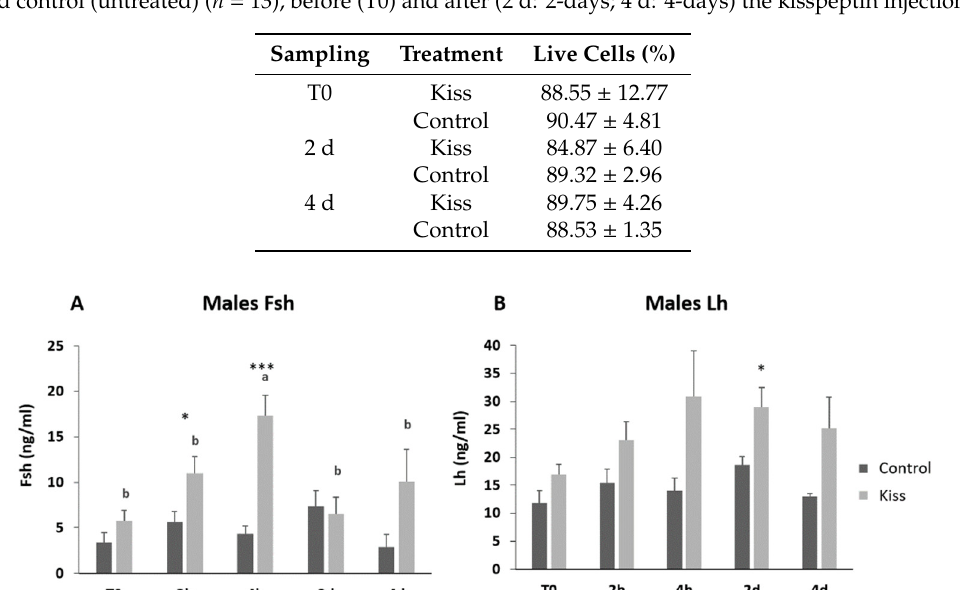
Figure 6. Sexual steroids plasma levels in ng/mL (mean ± SEM) from Senegalese sole males treated with kisspeptin hormone ( n = 17) and control ( n = 13). ( A ) Testosterone and ( B ) 11-Ketotestosterone